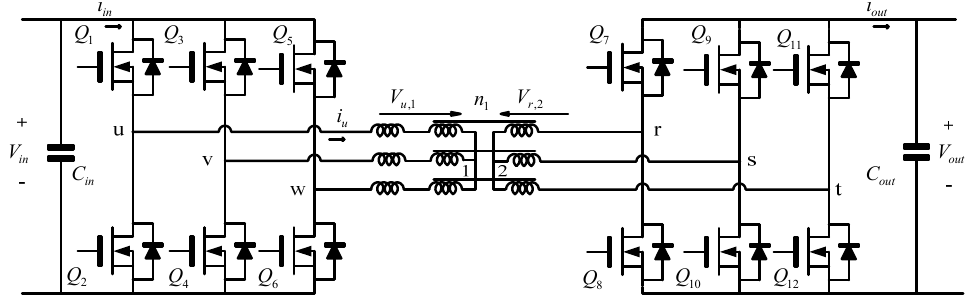
Figure 17. Three–phase Dual Active Bridge (DAB) converter [34].